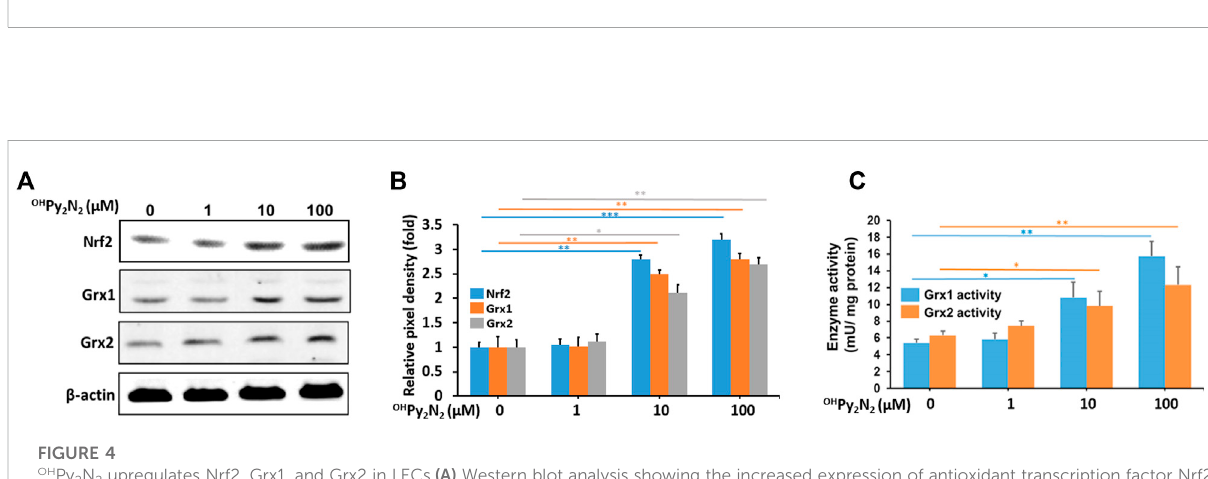
FIGURE 3 OH Py 2 N 2 reduces ROS production in H 2 O 2 -treated LECs. (A) LECs as a control with no treatment, (B) 200 μ M H 2 O 2 treatment for 30 min, and (C,D) pretreatment with 10 or 100 μ M OH Py 2 N 2 for 24 h followed by 200 μ M H 2 O 2 treatment for 30 min. (E) Fluorescence was detected using the probe CellROX orange reagent for all groups; fl uorescence intensity quanti fi ed and represented as the mean mean ± SEM of three independent experiments, ** p < 0.01, *** p < 0.01 compared with the H 2 O 2 -only group ( n = 3). Scale bar = 50 μ m.